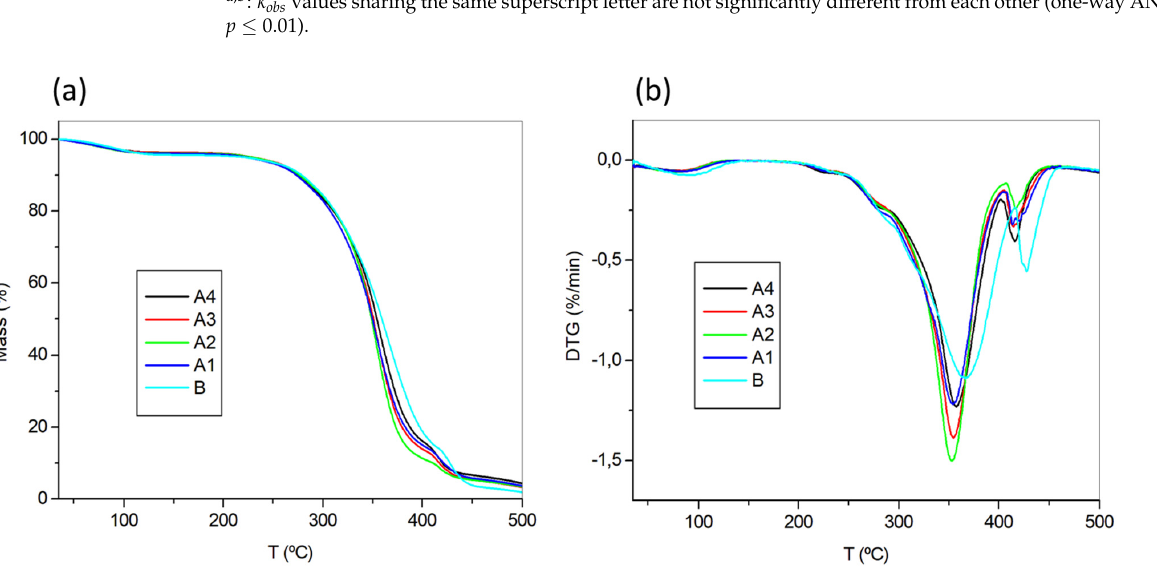
Figure 4. ATR-FTIR analysis of films A1 – A4 , B . The optical characterization of every film was carried out by UV-vis absorption spec- troscopy, taking advantage that the materials were transparent enough to make reliable direct measurements. Thus, placing the films in the optical path of the spectrophotometer yielded the spectra shown in Figure 5. Comparison of absorbance at 563 nm vs. RB con- centration follows a linear relationship, suggesting no important aggregation inside the